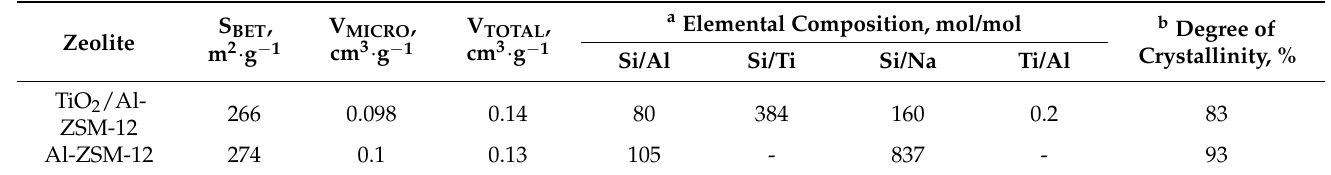
Figure 2. N 2 adsorption–desorption isotherms of synthesized zeolites. Table 1. Composition and textural characteristics of synthesized zeolites. Table 1. Composition and textural characteristics of synthesized zeolites.